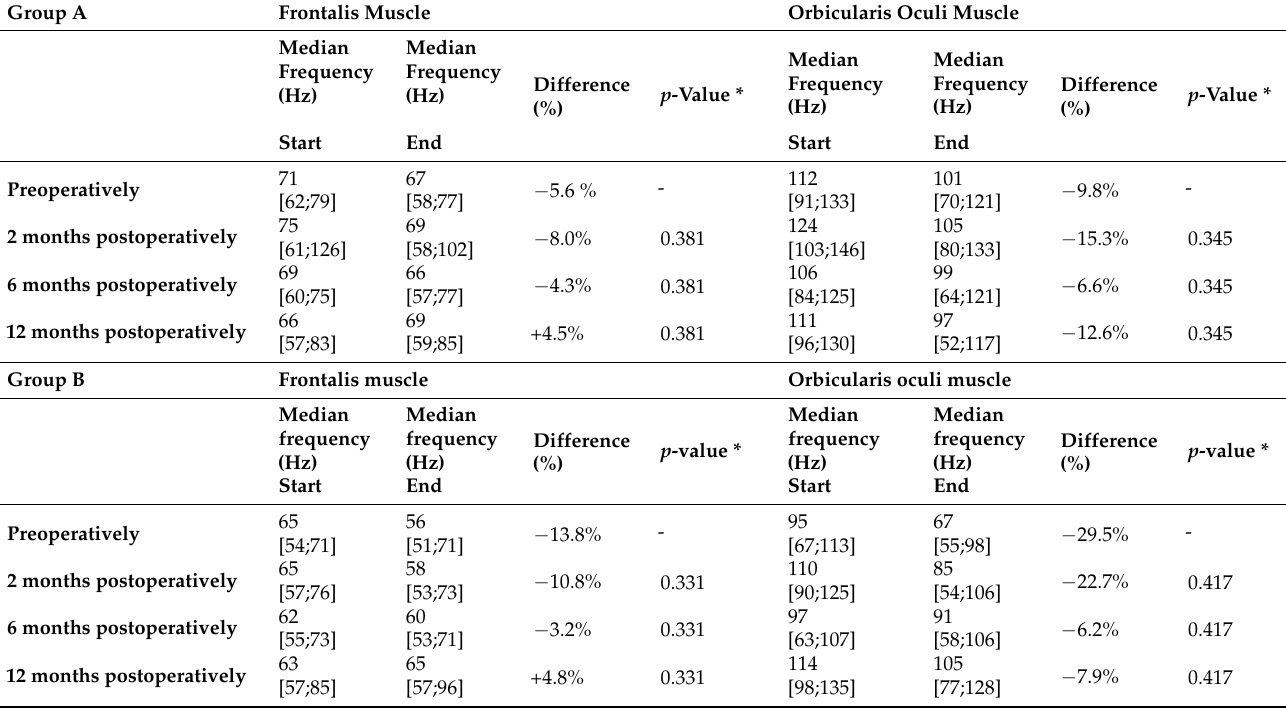
Table 6. Median frequency shift during maximal contraction (Fmed